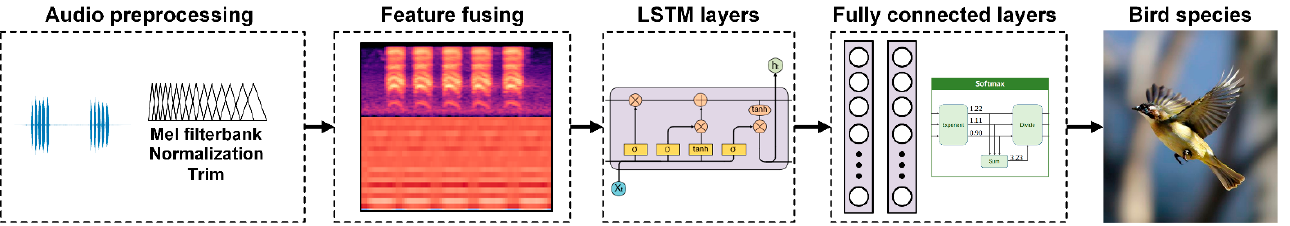
Figure 5. Process of bird species identification.